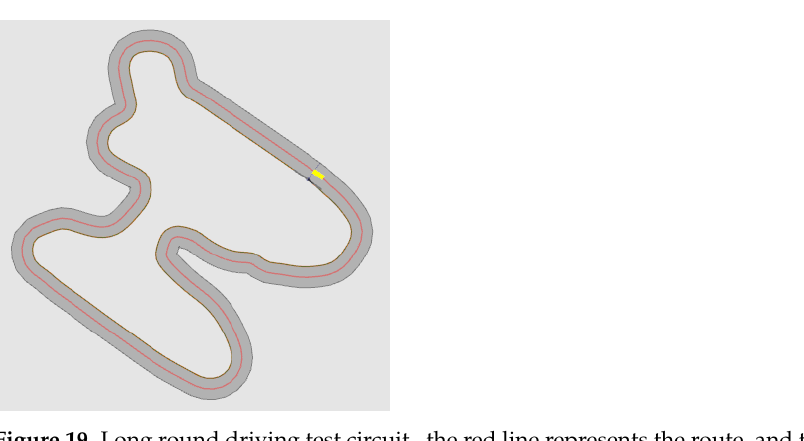
Figure 18. Short round driving test circuit , the red line represents the route, and the yellow square represents where the car starts driving.